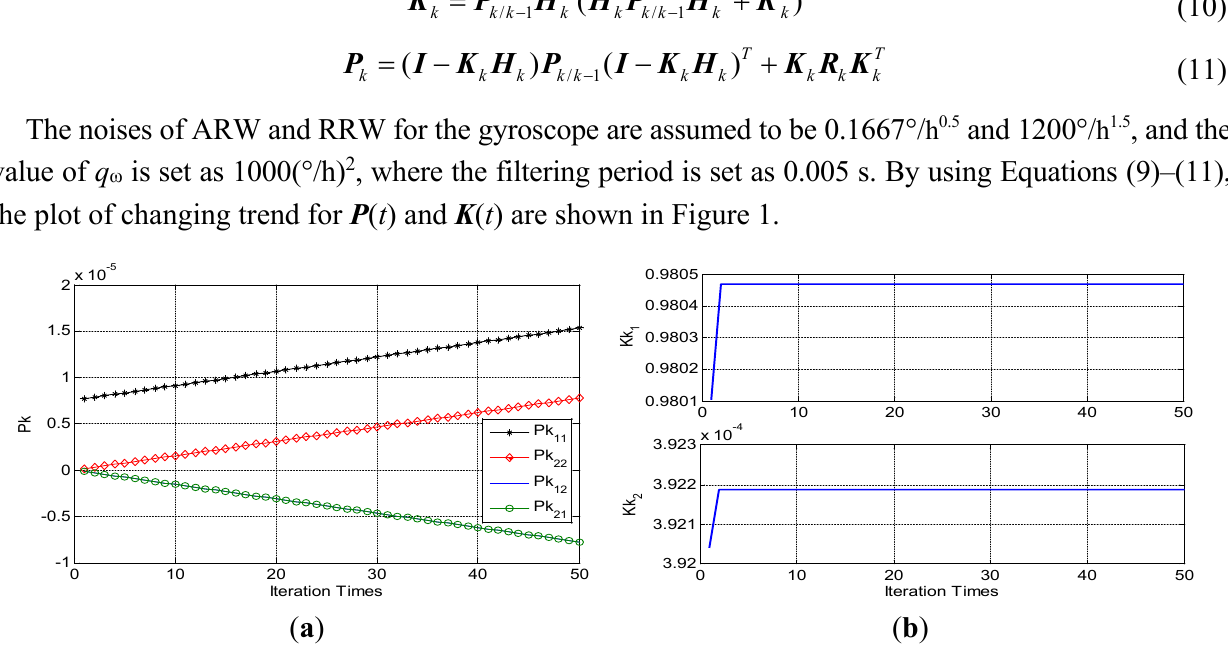
Figure 1. Plot of changing trend of the estimated covariance P ( t ) and filter gain K ( t ). ( a ) Kalman filter (KF) covariance P ( t ). ( b ) KF gain K ( t